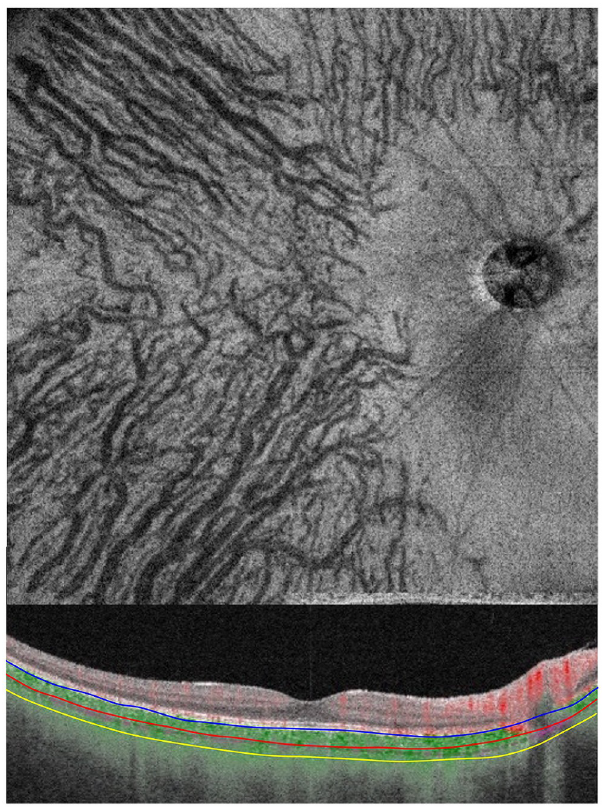
Fig 1. High-quality vascular en face image of the choroidal vascular structure at the selected segmentation slab of one-half of the subfoveal choroidal thickness.